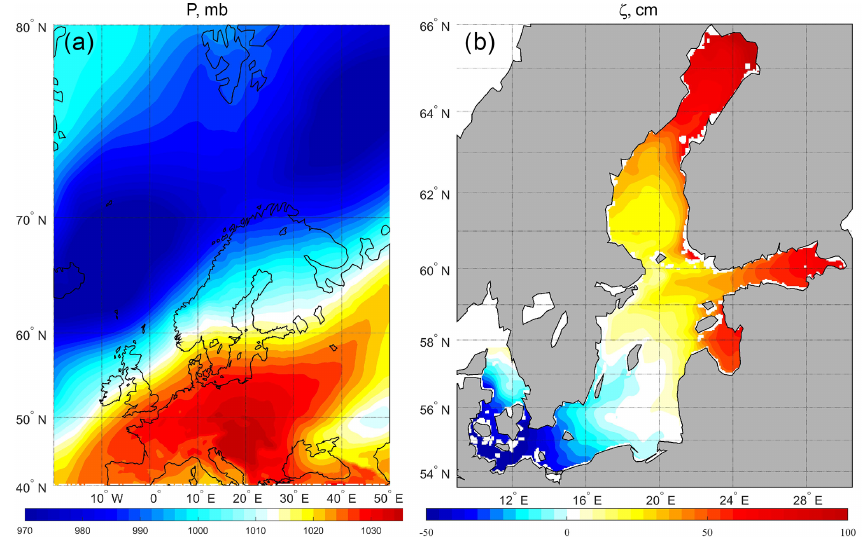
Figure 3. ERA-Interim atmospheric pressure (a) and INMOM SSH (b) for the moment of cessation of atmospheric forcing (10 January 2009,